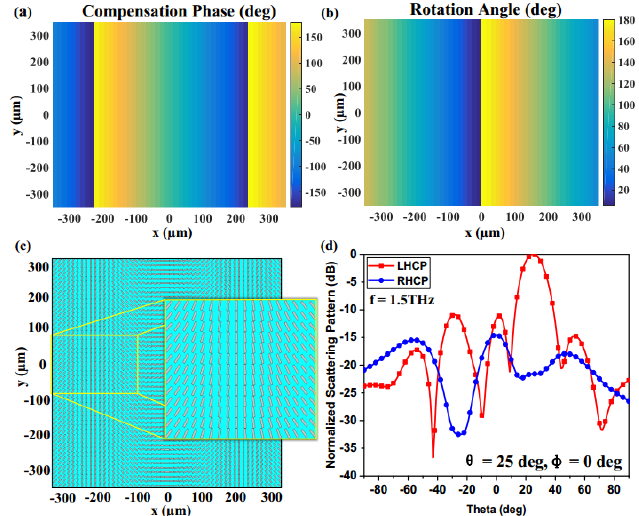
Figure 6. Simulation results for controlling the SAM of the reflected wave at ( θ , ϕ ) = (25 ◦ , 0 ◦ ): ( a ) Compensation phase pattern of the graphene metasurface; ( b ) rotation angle pattern of the graphene metasurface; ( c ) the element pattern of the metasurface; ( d ) 2D normalized scattering pattern of the graphene metasurface.